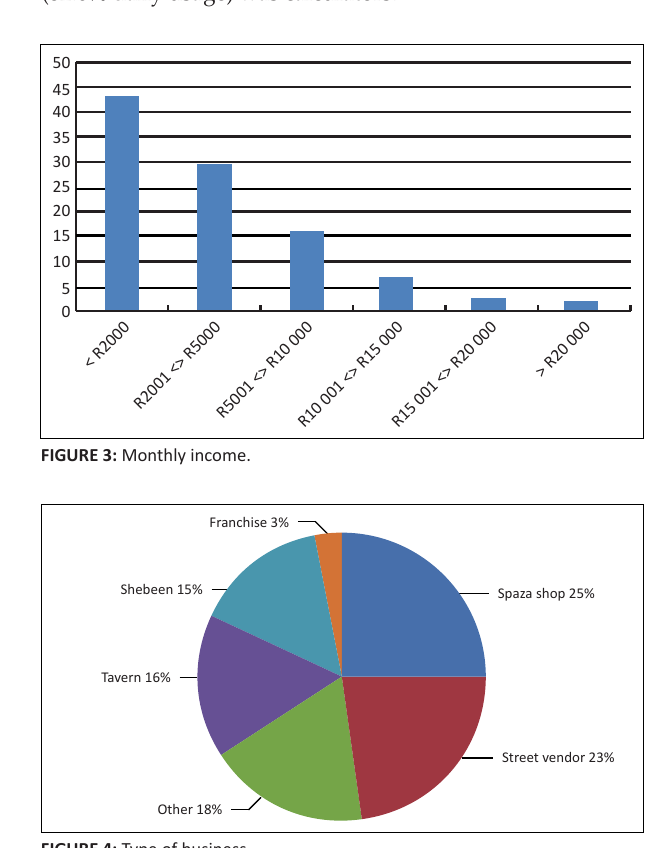
FIGURE 4: Type of